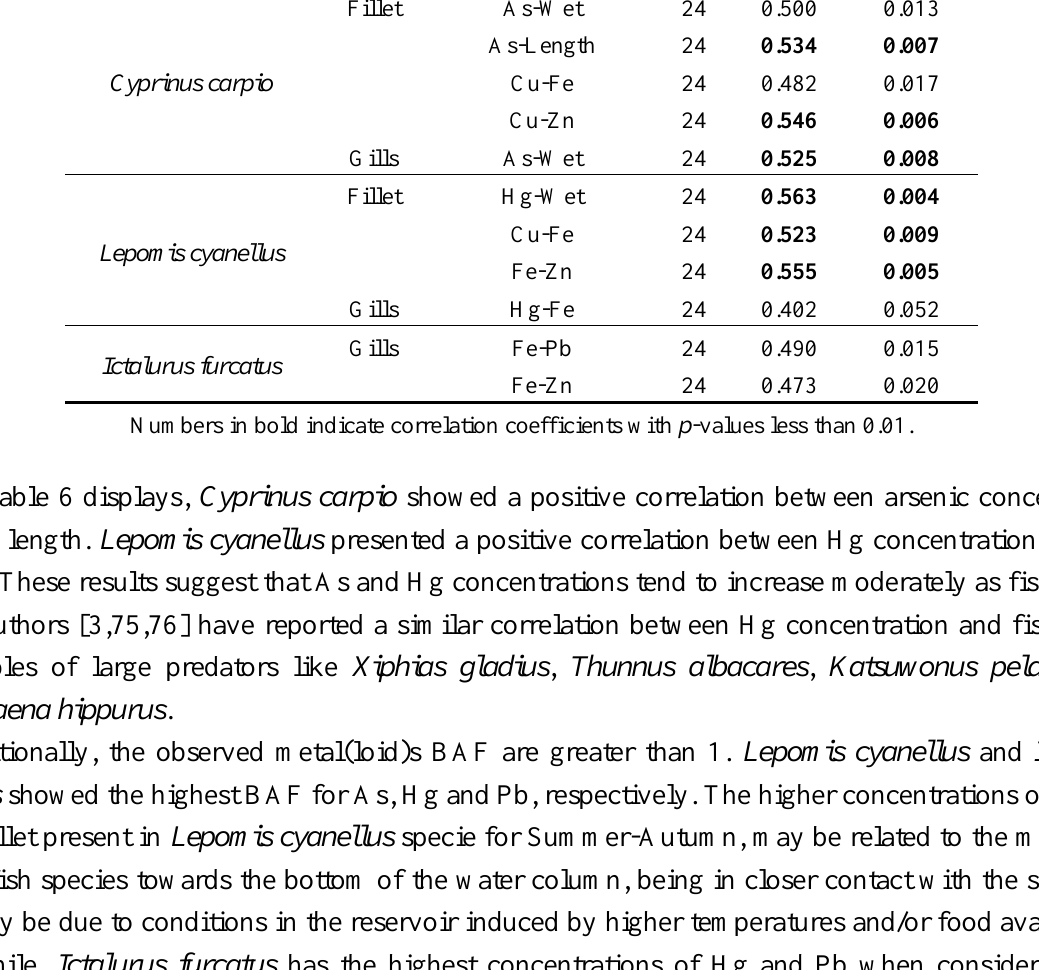
Table 6. Correlation coefficients of some parameters and metal(loid) concentrations in fillet and gill samples analyzed. Specie Tissue Correlation n r p -value